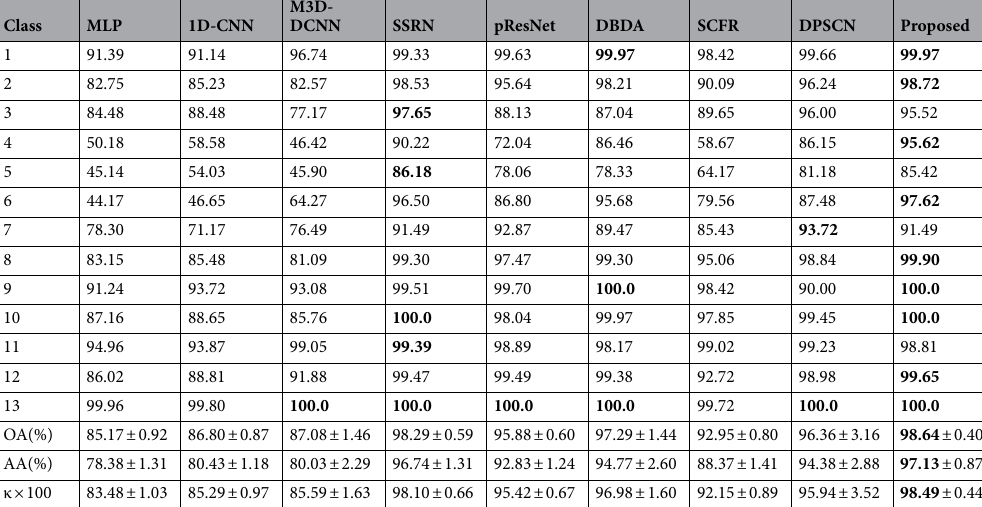
Table 5. Classification results of 5% samples of KSC dataset. Significant values are in bold.